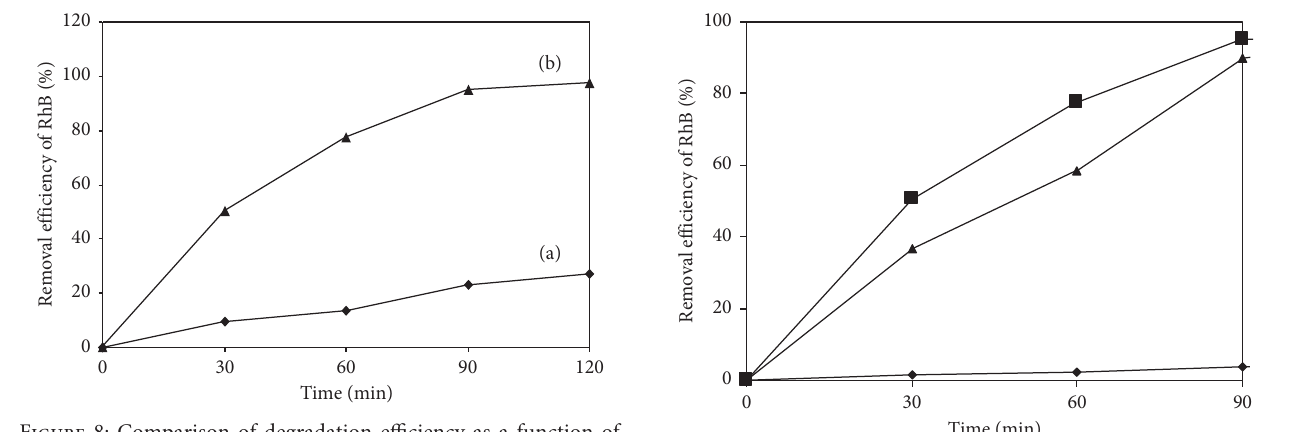
Figure 8: Comparison of degradation efficiency as a function of light irradiation time of TiO 2 (a) and C, N-TiO 2 (b).